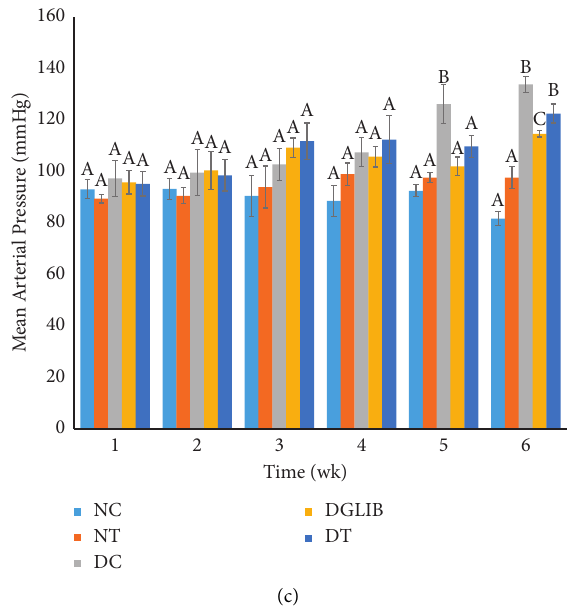
Figure 5: (a) The effect of the cocktail on the SBP of diabetic and euglycaemic S-D rats. Data are expressed as mean ± standard error of the mean and analysed by Tukey post hoc statistical test. NC: normal control, NT: normal treatment, DC: diabetic control, DT: diabetic treatment, and DGlib: diabetic glibenclamide group, where the letters represent the following: a, statistically significant differences when compared with the bars with letters b and c; b, statistically significant differences when compared with the bars with letters a and c; c, statistically significant differences when compared with the bars with letters a and b; ab, no significant difference when compared with the bars with either a or b. Significant difference is considered at p ≤ 0 . 05. (b) the effect of the nutritional supplement on the DBP of diabetic and euglycaemic S-D rats. Data are expressed as mean ± standard error of the mean and analysed by Tukey post hoc statistical test. NC: normal control, NT: normal treatment, DC: diabetic control, DT: diabetic treatment, DGlib: diabetic glibenclamide group, where the letters represent the following: a, statistically significant differences when compared to the bars with letters b and c; b, statistically significant differences when compared with the bars with letters a and c; c, statistically significant differences when compared with the bars with letters a and b; ab, no significant difference when compared with the bars with either a or b; bc, no significant difference when compared with the bars with either b or c. Significant difference is considered at p ≤ 0 . 05. (c) The effect of the nutritional supplement on the MAP of diabetic and euglycaemic S-D rats. Data are expressed as mean ± standard error of the mean and analysed by Tukey post hoc statistical test. NC: normal control, NT: normal treatment, DC: diabetic control, DT: diabetic treatment, and DGlib: diabetic glibenclamide group, where the letters represent the following: a, statistically significant differences when compared to the bars with letters b and c; b, statistically significant differences when compared to the bars with letters a and c; c, statistically significant differences when compared to the bars with letters a and b. Significant difference is considered at p ≤ 0 .